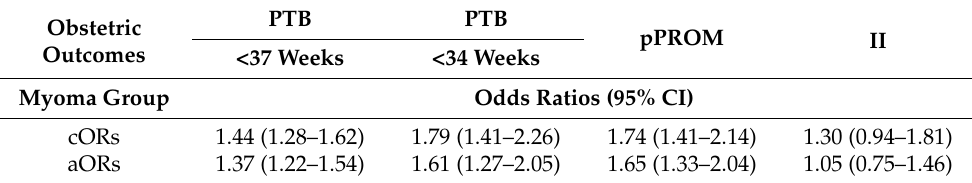
Table 2. Odds ratios for obstetric complications in the myoma